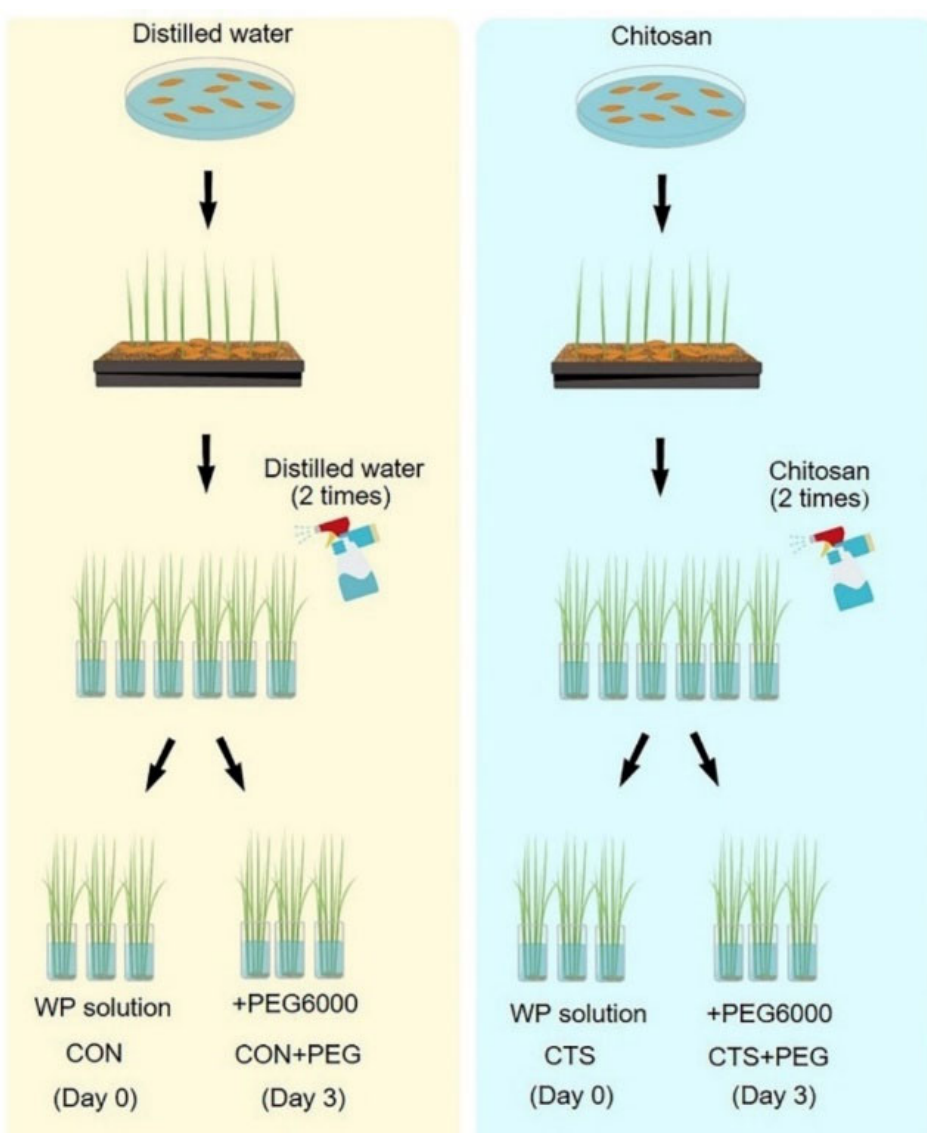
Figure 5. Scheme of the methodology for four different treatments: (1) CON, seedlings treated with distilled water; (2) CTS, seedlings treated with CTS; (3) CON + PEG, seedlings pretreated with distilled water followed by PEG6000; and (4) CTS + PEG, seedlings pretreated with CTS followed by PEG6000. Rice seedlings were harvested for phosphoproteome analysis on day 0 (CON and CTS) and day 3 (CON + PEG and CTS + PEG) after osmotic stress treatment.